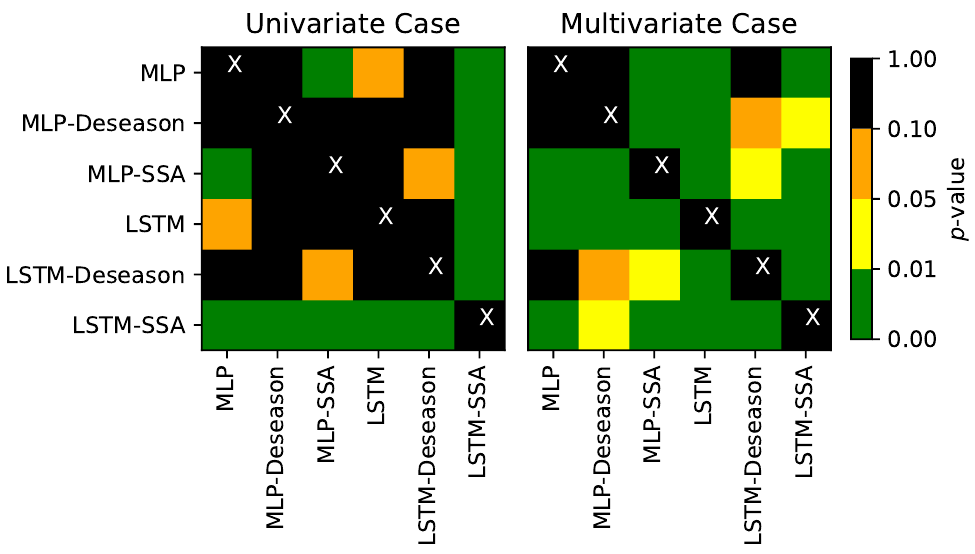
Figure 6. Pairwise DM tests to assess if difference in performance is statistically significant for the univariate ( left ) and the multivariate ( right ) cases. The null hypothesis states that each pair of forecasts have the same predictive accuracy. Green, yellow, and orange denote that the null hypothesis is rejected and that the results are statistically significant at the 1%,5%, and 10% levels, respectively. For p -value ≥ 0.10, the null hypothesis is not